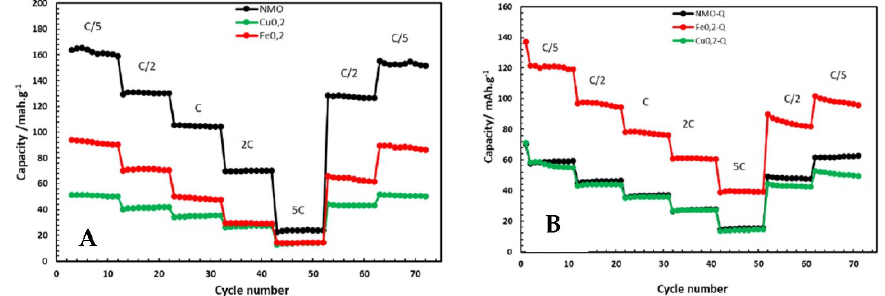
Figure 9. Discharge capacity values for slowly cooled ( A ) and quenched ( B ) samples.